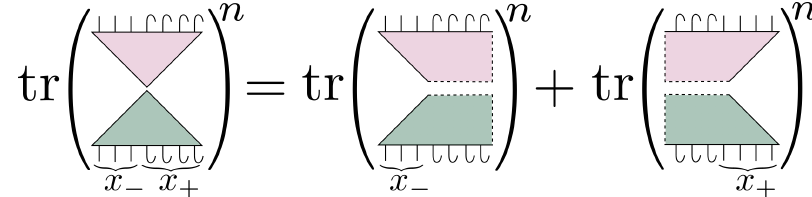
Figure 3: Pictorial illustration of the Conjecture 5.1. The entanglement of the spread- ing operator at time t is written as a sum of two contributions where the left and right boundary are respectively sent to